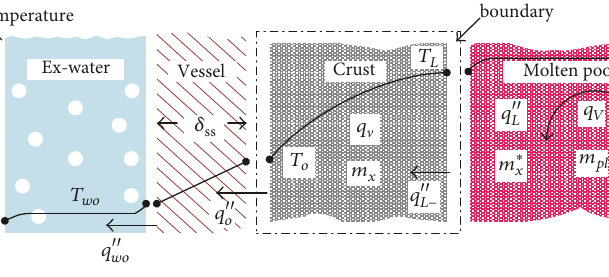
Figure 6: Nodal dynamic model of